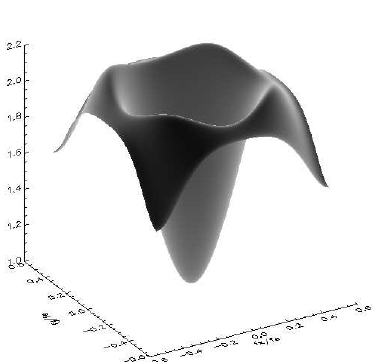
Figure 3 : PLEIADES-HR panchromatic deconvolution filter